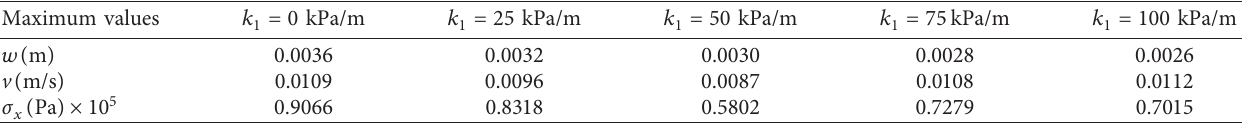
Table 6: Maximum deflections, velocities, and stresses at the central point of the FGP plate versus time. Maximum